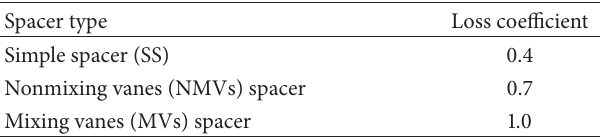
Table 7: Bundle average spacer pressure loss coefficients.